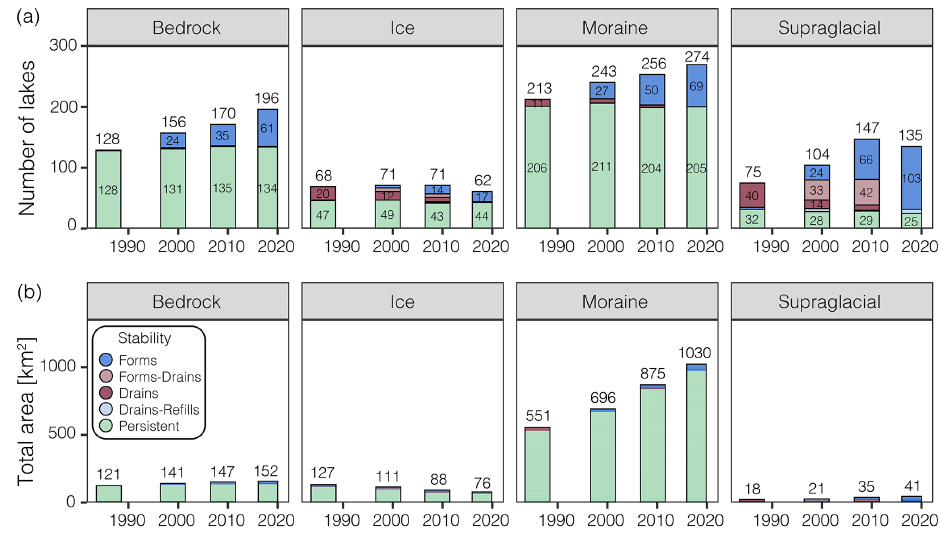
Figure 5. Number of lakes (a) and total area (b) of each dam type through time. The number of lakes in blue indicates the total number of lakes in that time period that were not present in 1984–1988; the number of lakes in red indicates the number of lakes present in that time period which drain in a subsequent time period. Light red indicates lakes which form after 1984–1988 but drain before 2016–2019. Bar widths correspond to imagery time